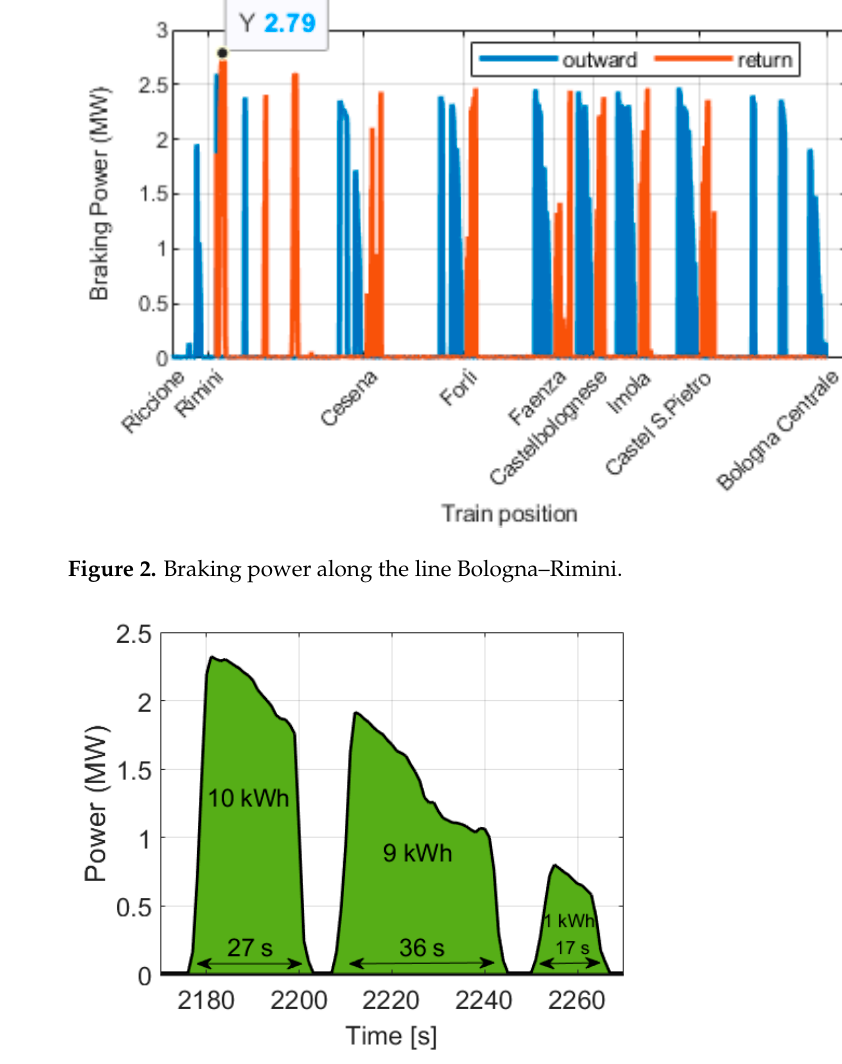
Figure 3. Power fluxes during a braking event.